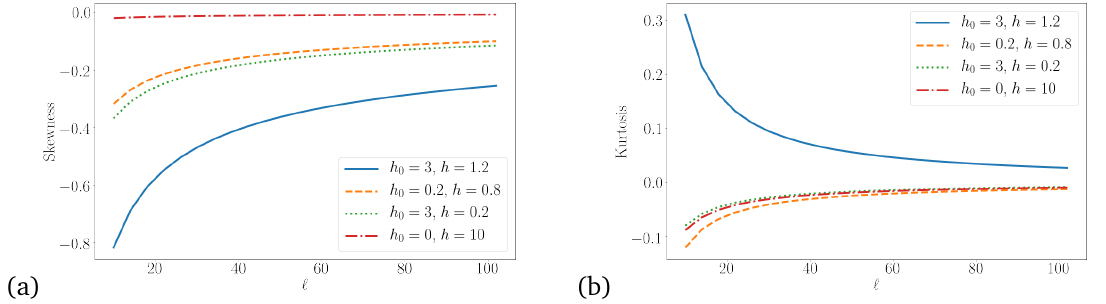
Figure 6: (a) Skewness and (b) Excess kurtosis of the steady state probability distri- bution as functions of subsystem size (cid:96) for a number of transverse field quenches. (cid:96) and t there is scaling collapse